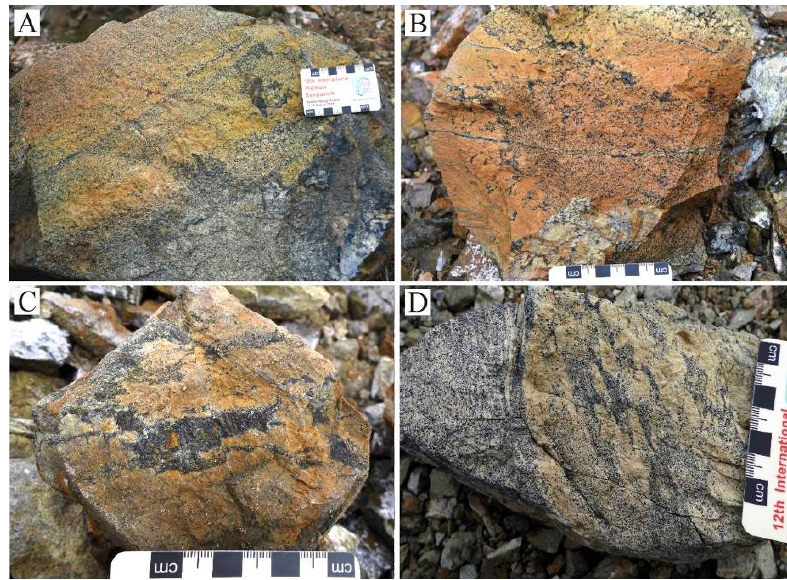
Figure 4. Different textural types of the chromite ores from the Alapaevsk massif, Central Urals. Chromite ore of the Kurmanovskoe deposit (number IV on map) ( A – C ). ( A ) Banded (sample PE1852) and massive (samples PE1855-1 and PE1856); ( B ) ores disseminated ore; ( C ) small schlieren of massive chromitite; ( D ) schlieren type of chromitite from the Bakanov Kluch chromite deposit (sample PE1870) (Ion map).